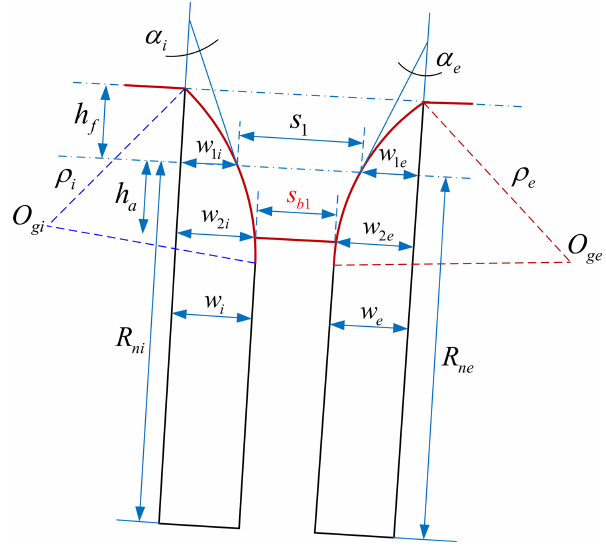
Figure 5. Geometric representation of the worm tooth width s b 1